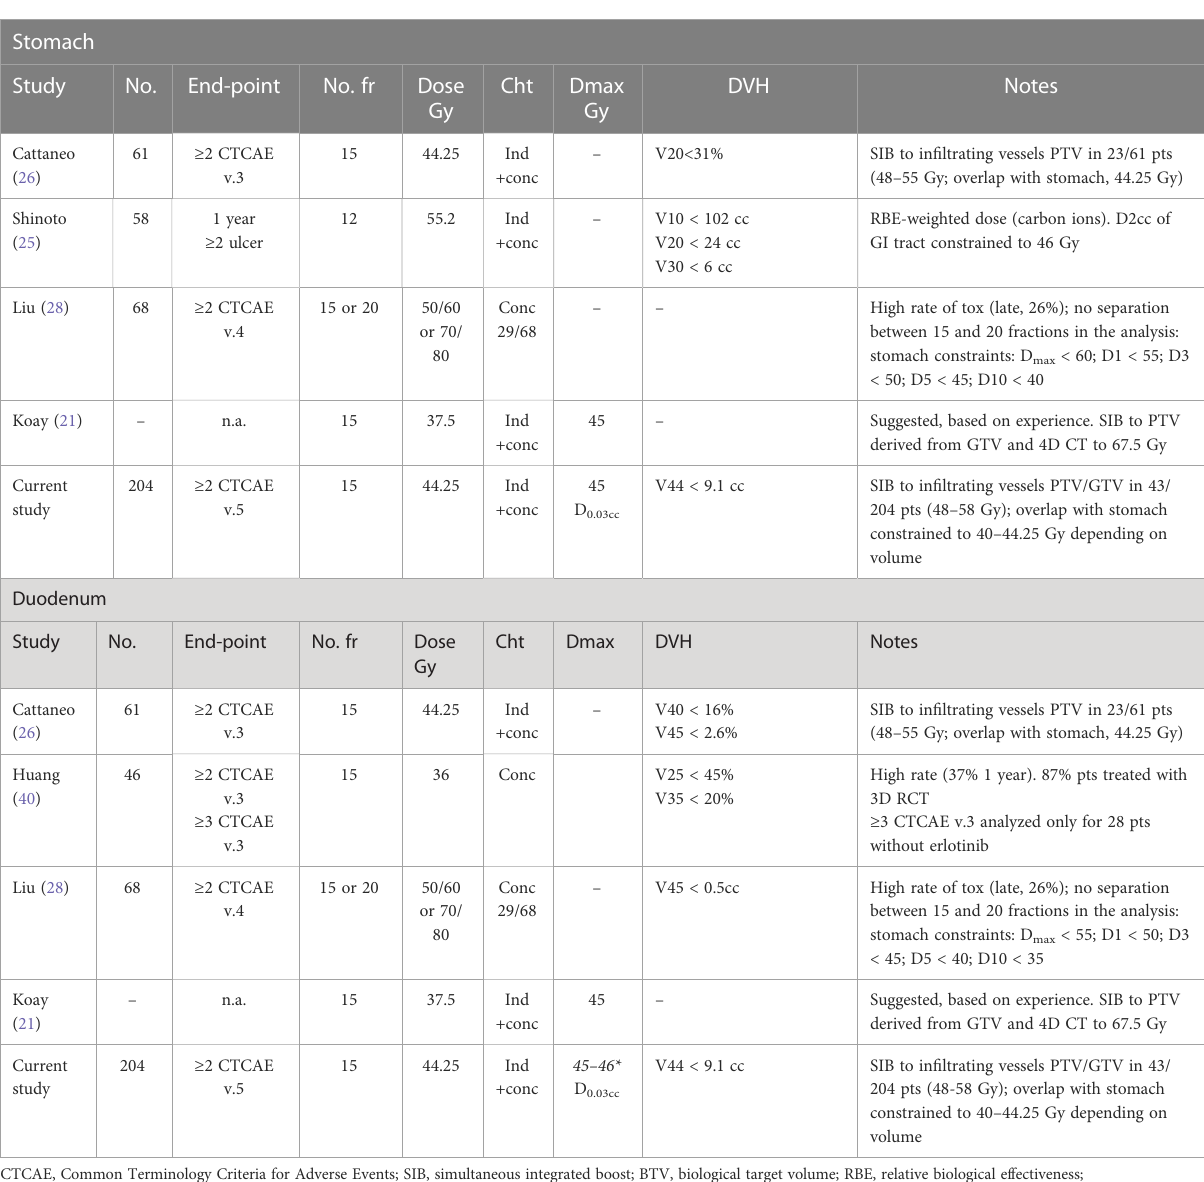
TABLE 2 Summary of the literature for moderate